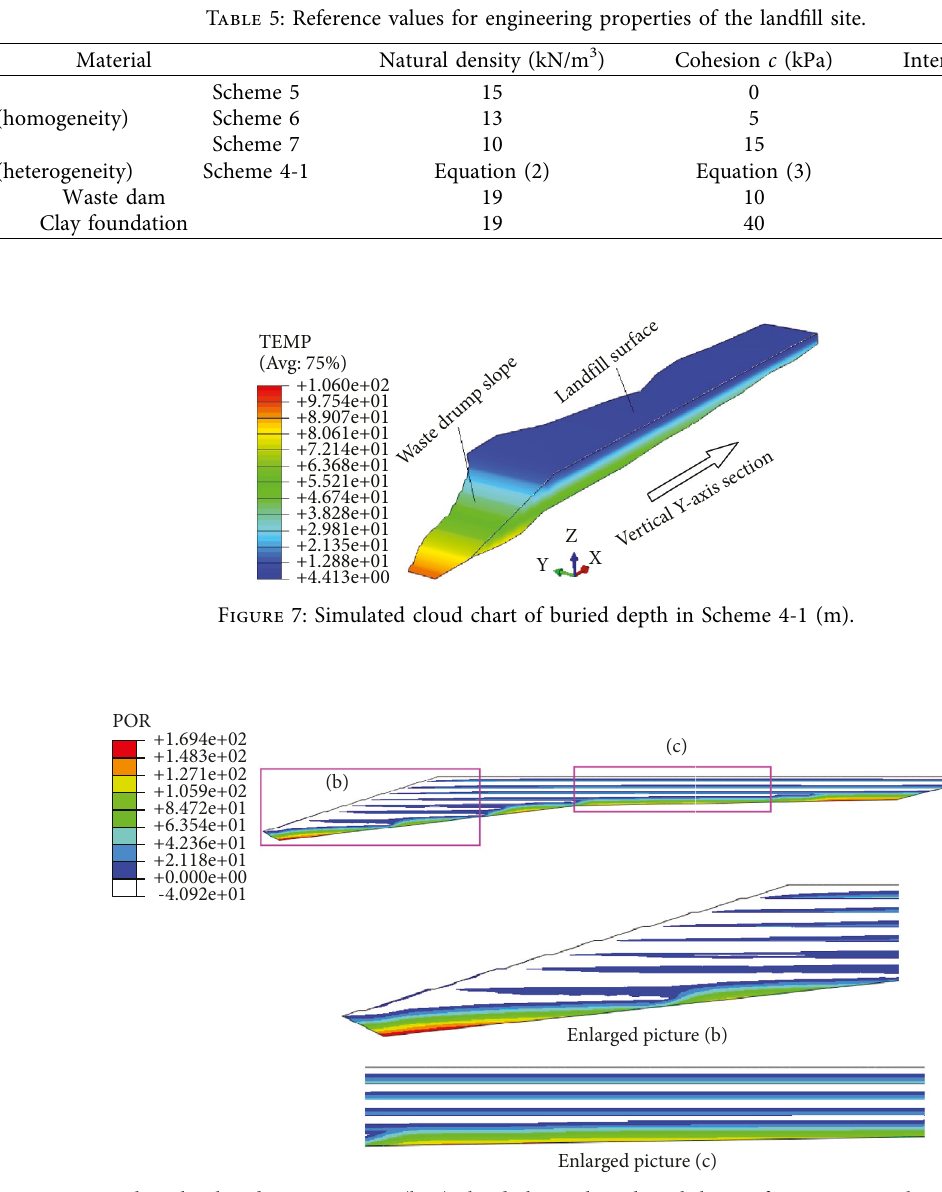
Figure 8: Leachate level and pore pressure (kPa) cloud chart when the 9th layer of waste is completed in Scheme